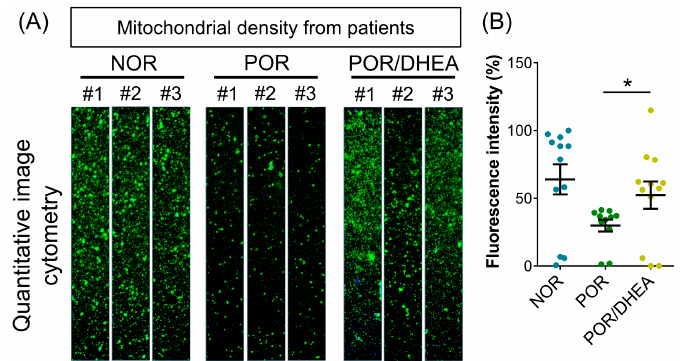
Figure 3. DHEA supplementation improved mitochondrial mass of cumulus cells (CCs) in poor ovarian responders. ( A ) CCs were stained with MitoTracker, and the mitochondrial mass was measured by real-time image cytometry. ( B ) The relative mean of fluorescent intensity was calculated among the eight groups. Data represented the mean ± SEM of nine independent experiments. * p < 0.05.